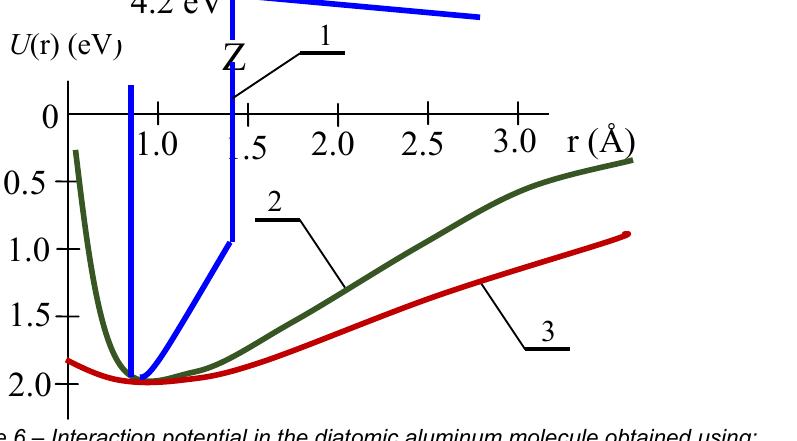
Figure 6 – Interaction potential in the diatomic aluminum molecule obtained using: 1 - formula (25); 2 - Lennard-Jones formula; 3 - Morse formula